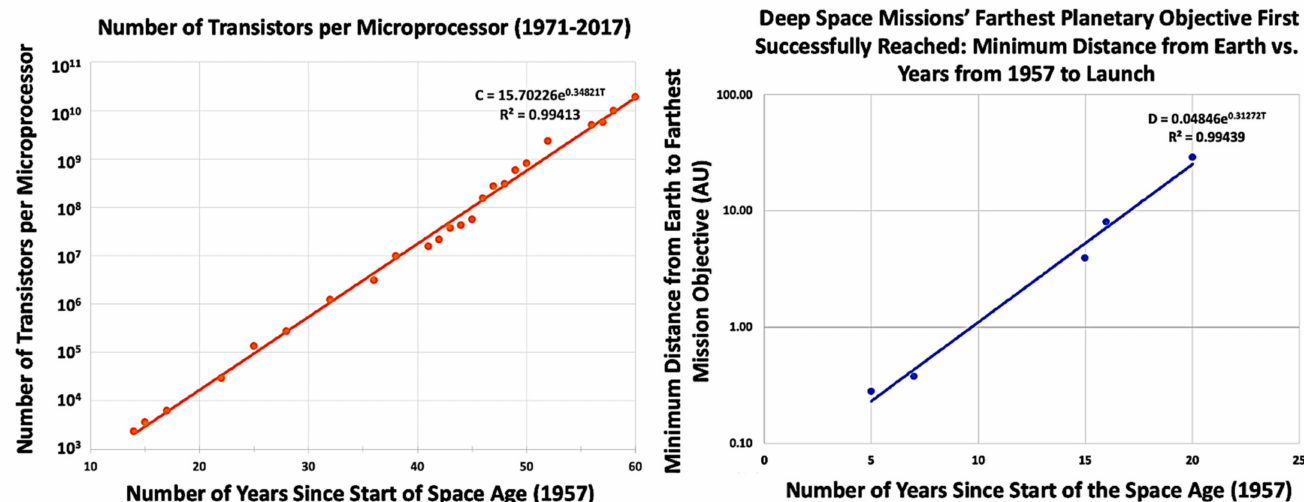
Figure 1. Left-panel : Computational power as expressed in number of transistors per microprocessor from 1971 to 2017, time expressed as number of years since start of the Space Age (1957), used in empirically derived Equation (1) [17]; Right-panel : First of their kind robotic deep space missions’ (flybys) planetary objective minimum distance from Earth orbit (in astronomical units) vs. number of years from start of Space Age (1957) to missions’ launch year, used in empirically derived Equation